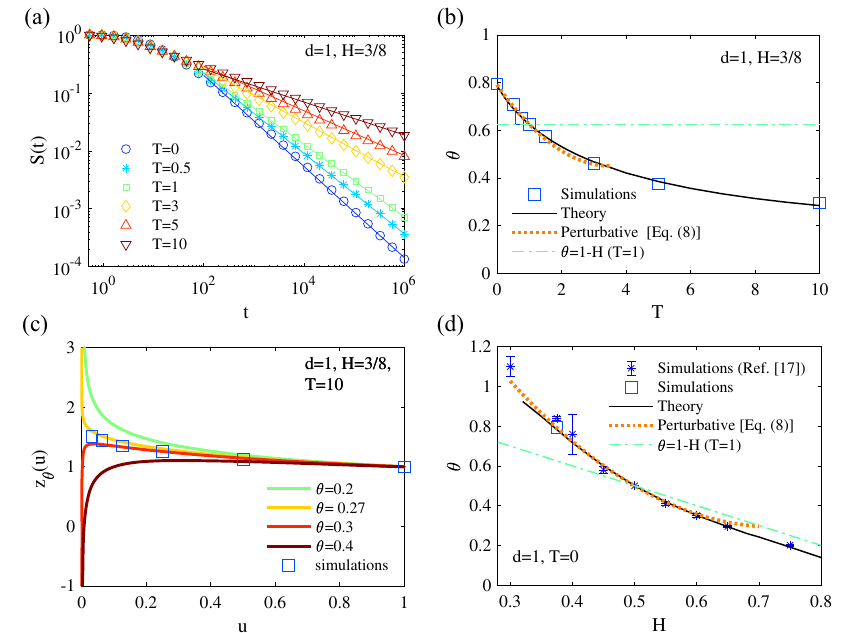
Fig. 1 | Persistence for quenched fBM (type I problem) in d =1. a Example of survivalprobabilitiesforinterfacedynamicswith H =3/8atdifferenttemperatures. The slopes of the continuous lines is the value of θ predicted in our approach. b Systematic comparison of θ as measured insimulations versus theoreticalvalues fordifferent T and H =3/8. c Value of z θ ( u ) as measured insimulations(squares)by